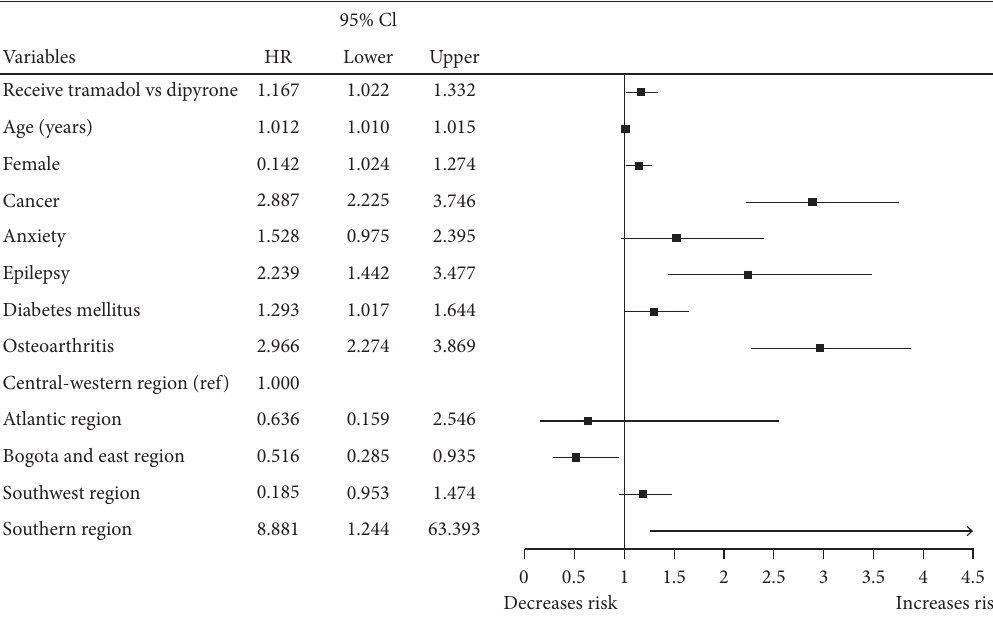
Figure 3: Cox regression of tramadol versus dipyrone on the probability of receiving a new opioid up to 12 months of follow-up after being treated in emergency departments of five clinics in Colombia,